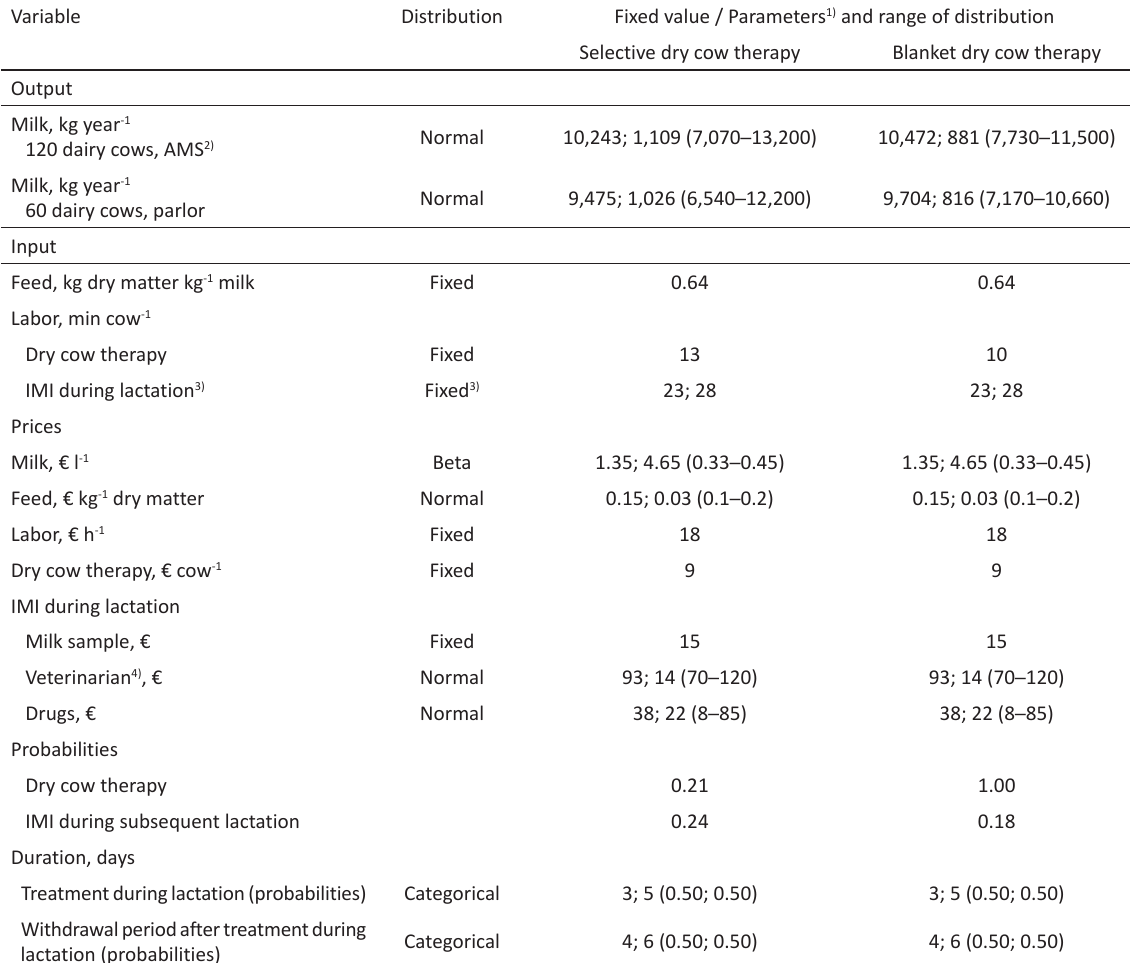
Table 1. Parameters for a stochastic calculation model for farms implementing selective versus blanket dry cow